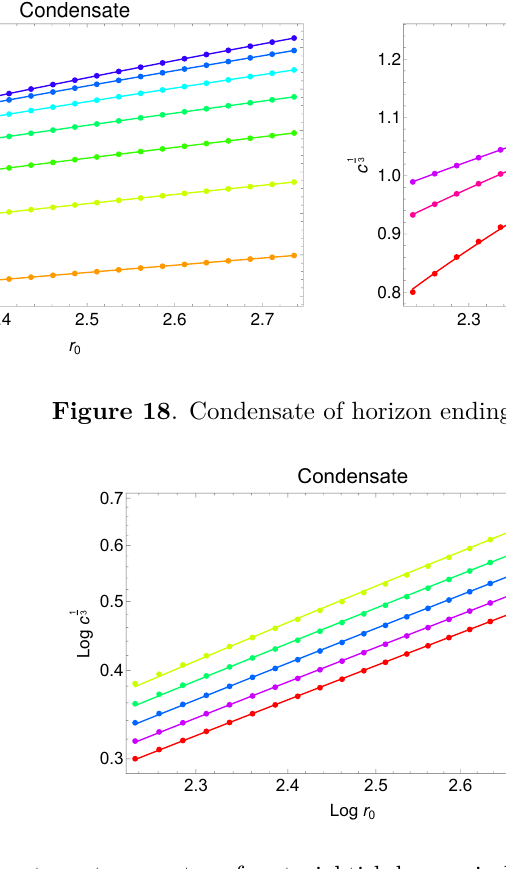
. The least value ( m = 2 . 7 ) is shown q q = 3 . 2 ) is shown in red. The log-log plot shown q